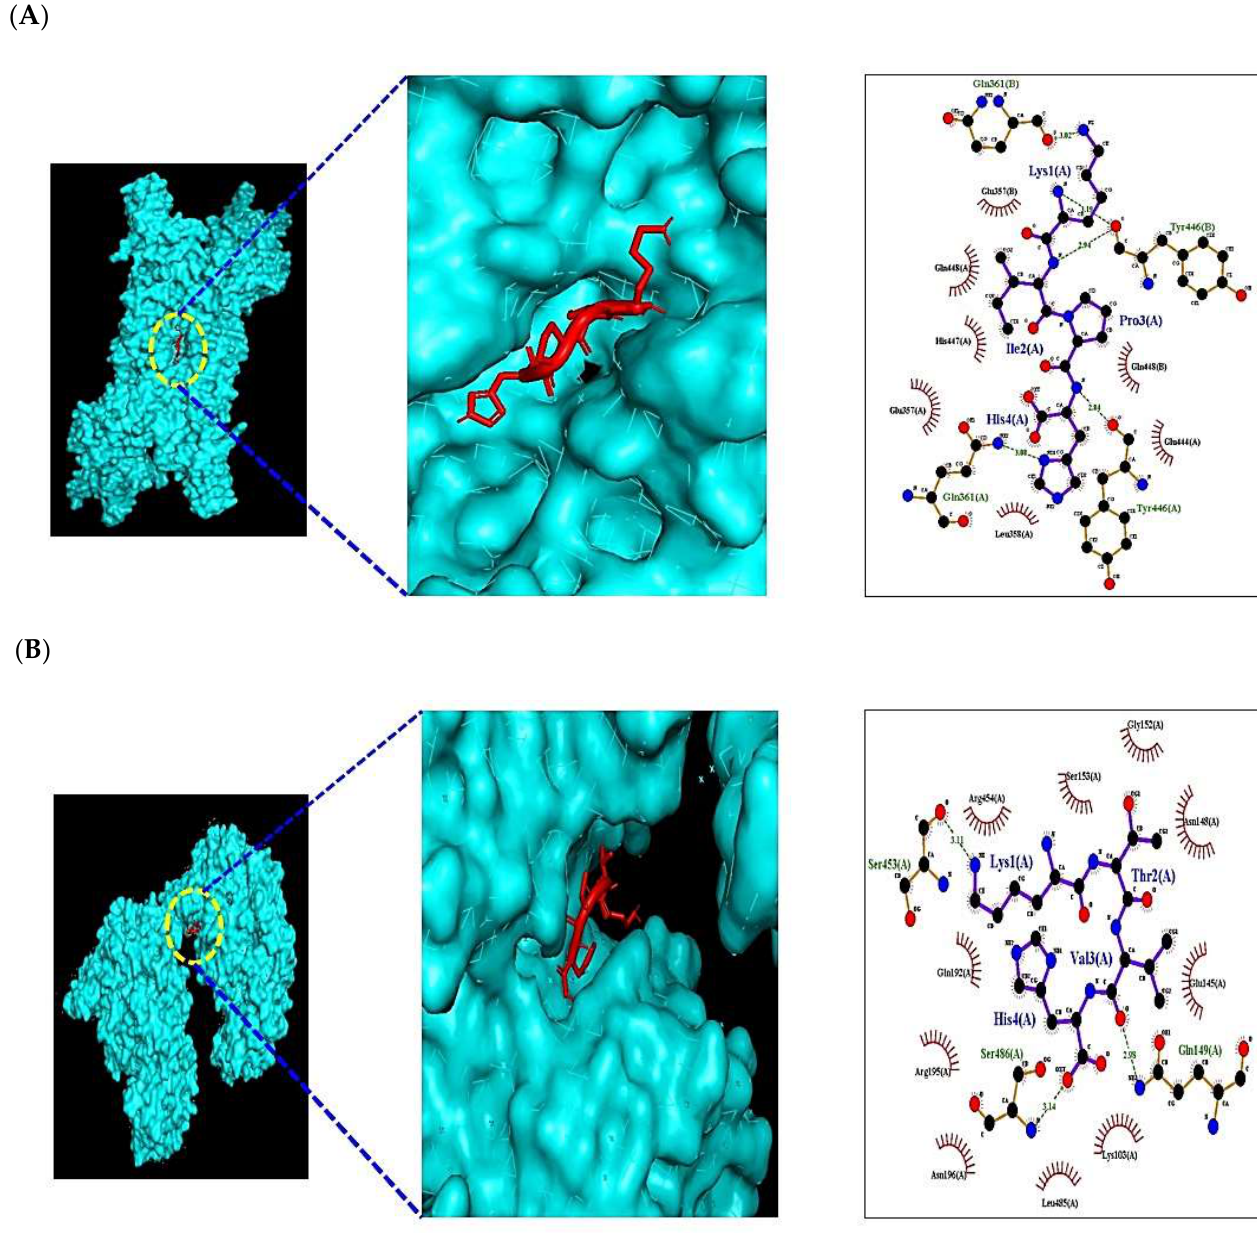
Figure 7. Molecular docking interaction between best-docked SCPs and targets. ( A ) HPIK on